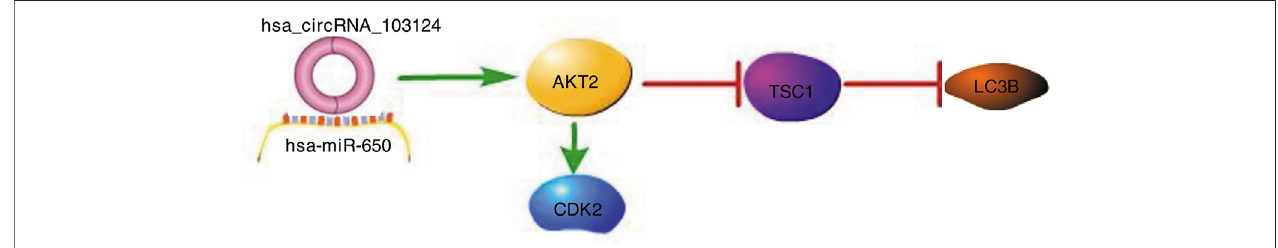
FIGURE 7 | Hsa_circRNA_103124 upregulated in patients with CD inhibits autophagy by targeting AKT2 and sponginghsa-miR-650. A schematic diagram of the proposed mechanism bywhich that hsa_circRNA_103124 upregulation inpatientswith CD inhibits autophagyby targeting AKT2 and sponginghsa-miR-650.Pathway Builder Tool 2.0 was used to create this diagram. Upregulated hsa_circRNA_103124 in patients with CD targets to hsa-miR-650. AKT2, a downstream protein of hsa- miR-650, is upregulated, which leads to increased expression of CDK2 and reduced expression of TSC1 and LC3B. Therefore, the proliferation of intestinal epithelial cells is increased, while autophagy is